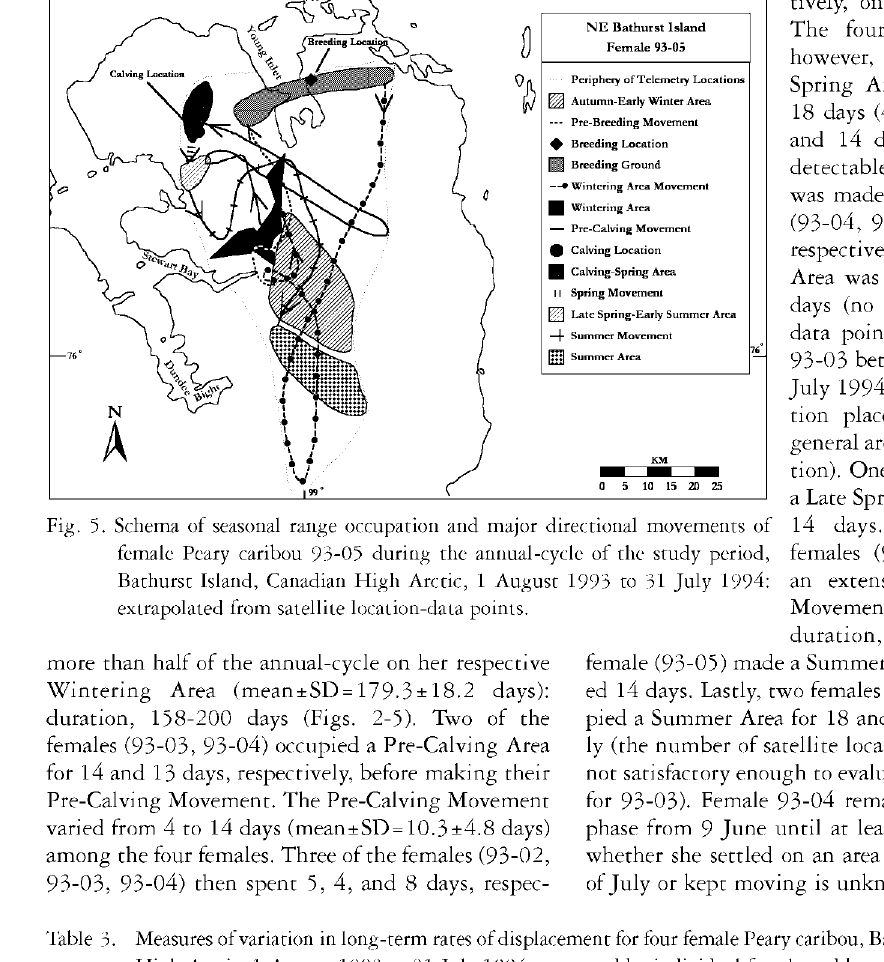
Table 3. Measures of variation in long-term rates of displacement for four female Peary caribou, Bathurst Island, Canadian High Arctic, 1 August 1993 to 31 July 1994: presented by individual female and by movement